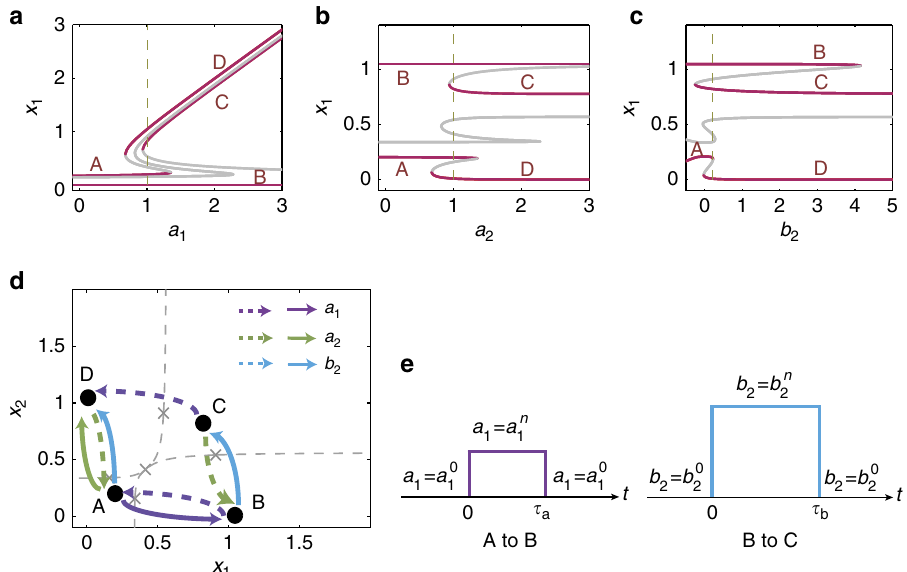
Figure 5 | Attractor network construction for a GRN of two nodes. ( a – c ) Bifurcation diagrams with respect to the coupling parameters a 1 , a 2 and b 2 , respectively, where each bifurcation point can be exploited to design control. ( d ) The corresponding attractor network, in which a directed edge corresponds to an elementary control that is designed to steer the system from the original attractor to the directed one. The solid and dashed edges, respectively, denote the positive and negative changes in the corresponding control parameters. ( e ) Sequential control signals required to drive the system from attractor A to attractor C through the path A - B - C . In simulation, the original parameter values are a 0 4 : 2, and the respective durations of the parameter perturbation are t a ¼ 23 and t b ¼ setting b n 2 ¼